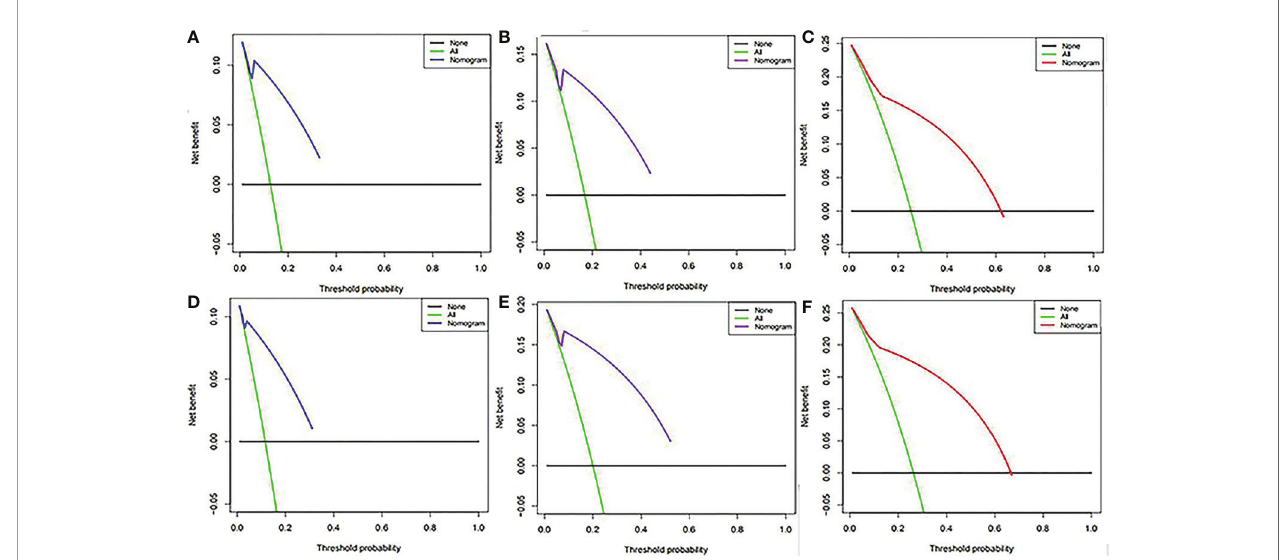
FIGURE 5 | Decision curve analysis of the nomogram for predicting PFS at 1-, (A) 2-, (B) and 5-year (C) points in the original model and PFS at 1- (D) , 2- (E) and 5-year (F) points in the validation model. The percentage of threshold probability was represented by the x-axis, whereas the net bene fi t was represented by the y-axis, calculated by adding the true positives and subtracting the false positives.